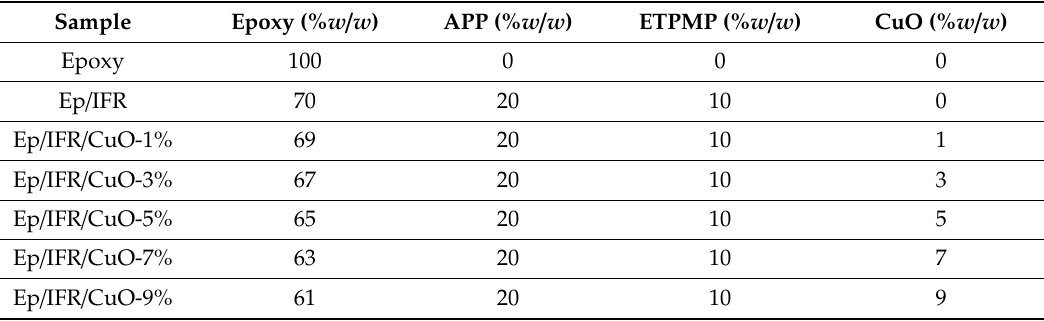
Table 6. Composition of the